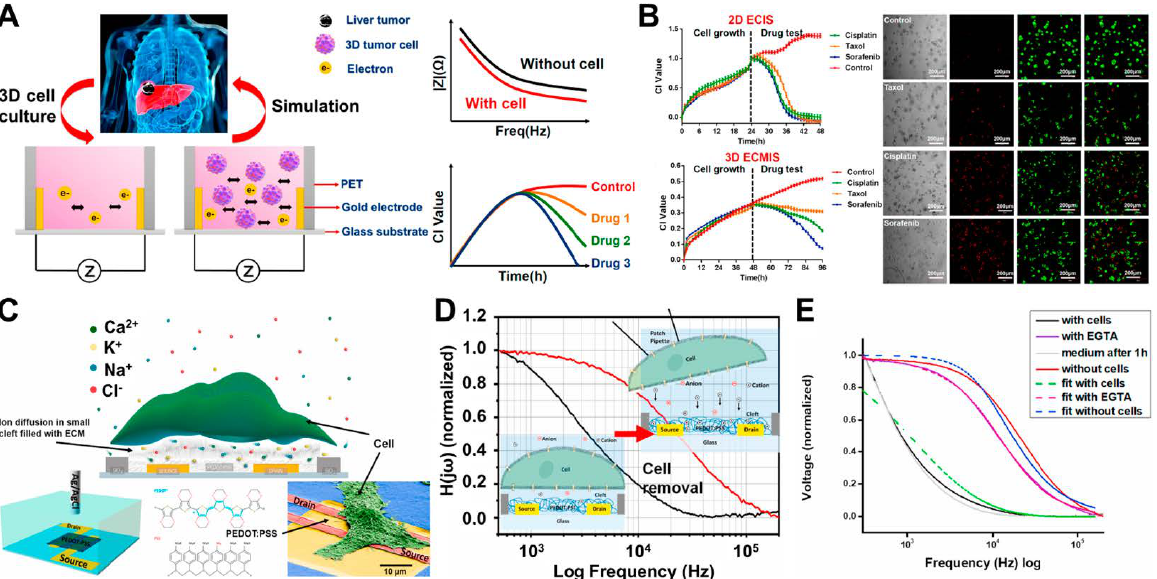
Figure 2. ( A ) Principle of the 3D ECMIS system for live-cell monitoring. ( B ) Cell-growth curves of 2D/3D-cultured HepG2 cells exposed to various anticancer drugs (cisplatin, taxol, and sorafenib) on a 2D/3D ECIS. Changes in the cell density and morphological characteristics of the 3D-cultured HepG2 cells analyzed by live–dead staining at 96 h. ( C ) Schematic of PEDOT:PSS OECT devices and a colored scanning electron microscopy (SEM) image of a fixated HEK 293 cell. ( D ) Detaching the cell from the OECT gate increases the low-pass frequency of the device’s transfer function from 2 kHz to greater than 10 kHz. ( E ) Strong attenuation of the spectrum with MDCK cells adhered to the OECT (black), added with EGTA (purple), removed from the surface (red), adherent cells (green), spectrum with opened gap junctions (pink), and fitted cells (blue). Reprinted with permission from [70]. Copyright 2019, Elsevier; reprinted with permission from [75]. Copyright 2021, Elsevier.